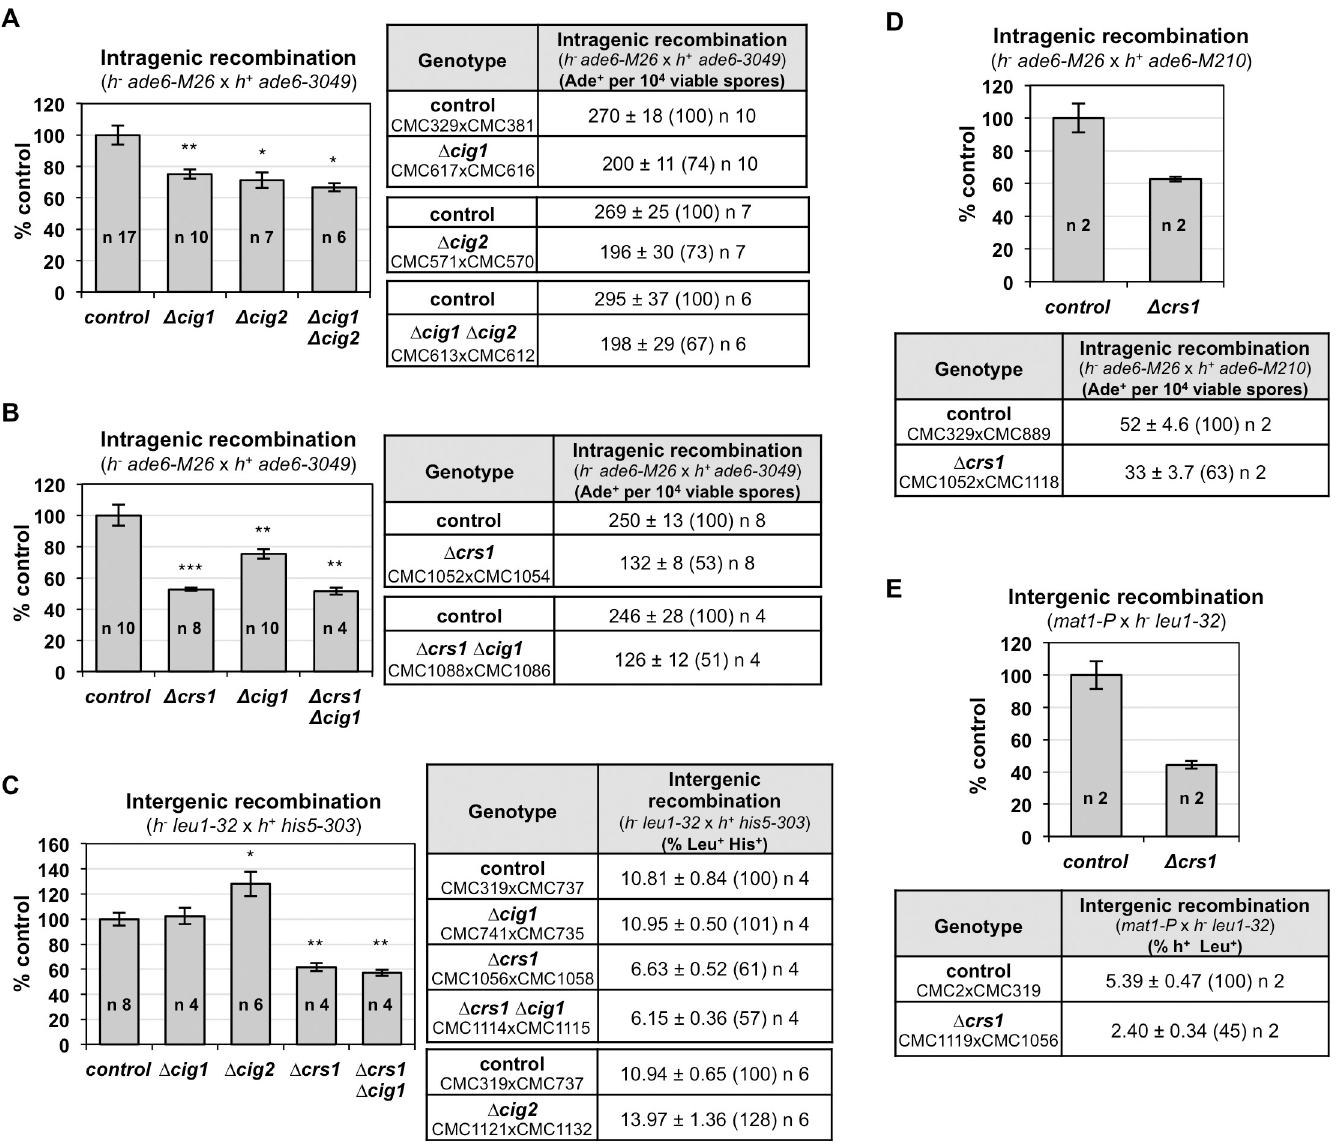
Fig 1. Cyclin deletion mutants impair meiotic recombination. (A) and (B) Crosses of h - ade6-M26 x h + ade6-3049 were performed in MEA and plated for recombinant frequency at least twice. Table on the right shows gene conversion expressed as the mean of Ade + per 10 4 viable spores +/- SEM of n independent crosses based on the cumulative number of spore colonies in each cross; 91–1236 Ade + colonies scored in each independent cross. The numbers in parentheses are percentages relative to wild-type control. Strains used in the crosses are indicated. Graph on the left shows gene conversion expressed as mean of the percentage relative to the control cross +/- SEM of n independent crosses. Each mutant was analyzed only with its control cross in the same experiment. (C) Crosses of h - leu1-32 x h + his5-303 in MEA were performed and plated for recombinant frequency twice. Table on the right shows crossover levels expressed as the mean of the percentage of recombinants +/- SEM of n independent crosses based on the cumulative number of spore colonies in each cross; 667–2763 haploid spore colonies analyzed in each plating. The numbers in parentheses are percentages relative to wild-type control. Strains used in the crosses are indicated. Graph on the left shows crossovers expressed as mean of the percentage relative to the control cross +/- SEM of n independent crosses. Each mutant was analyzed only with its control cross in the same experiment. (D) Crosses of h - ade6-M26 Δ crs1 x h + ade6-M210 Δ crs1 in MEA were performed and plated for recombinant frequency twice. Data representation as in (A) of 2 independent crosses based on the cumulative number of spore colonies in each cross; 580–1131 Ade + colonies scored in each independent cross. (E) Crosses of h + Δ crs1 x h - leu1-32 Δ crs1 in MEA were performed and plated for recombinant frequency twice. Data representation as in (C) of 2 independent crosses based on the cumulative number of spore colonies in each cross; more than 965 haploid spore colonies analyzed in each plating. p values were calculated based on Student´s t-test (unpaired, two tails), � < 0.05, �� � 0.01, ��� �